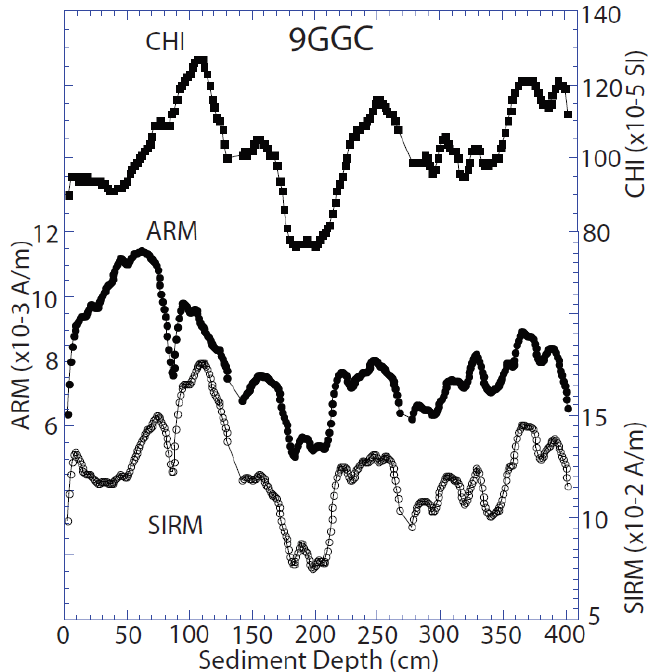
Figure 2. Rock magnetic intensity variability of gravity core 9GGC. Individual rock magnetic intensities are shown as Chi, anhysteretic remanence (ARM), and saturation isothermal remanence (SIRM) values. See text for further discussion.